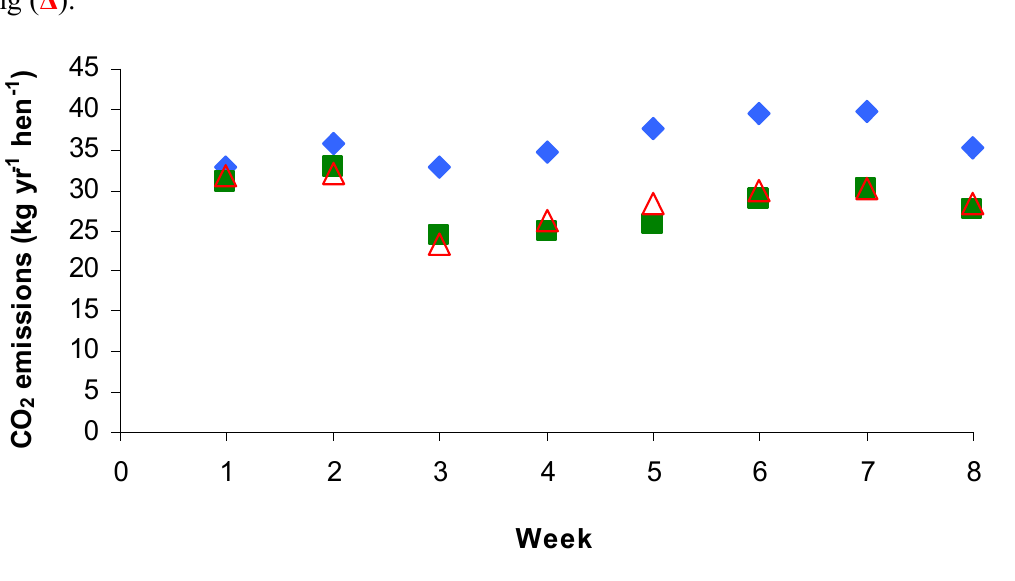
Figure 3. Mean weekly carbon dioxide emissions from three housing systems: deep liquid manure pit ( ♦ ), manure belt with natural drying ( ■ ) and manure belt with forced air drying ( Δ